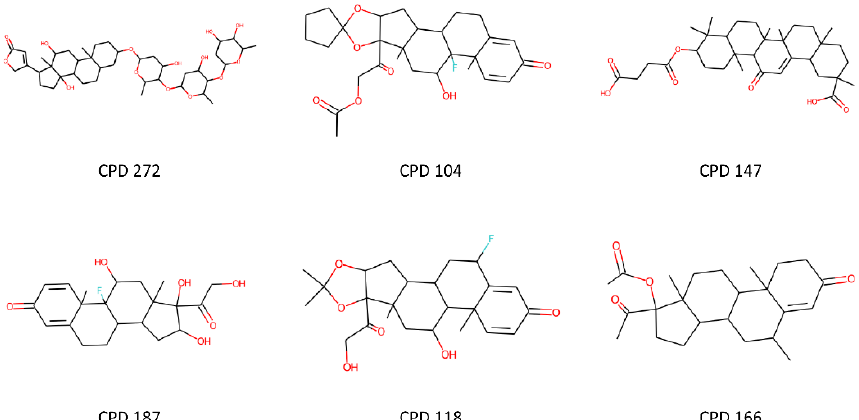
Figure 4. Non-hepatotoxic compounds sharing a steroid scaffold misclassified by the reference model from VEGA and correctly predicted by our consensus approach.